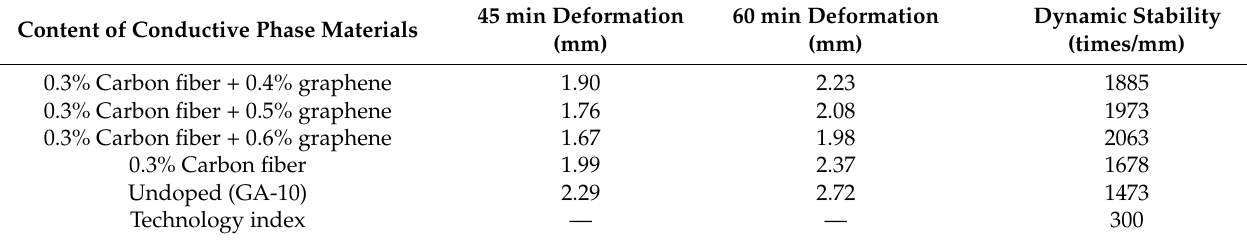
Table 12. Results of rutting test for asphalt mixture.